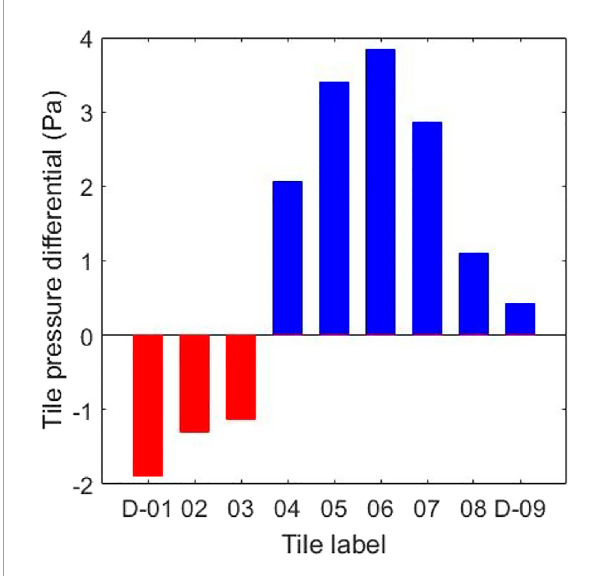
FIGURE 8 Pressure differential vs . location for passive tiles.